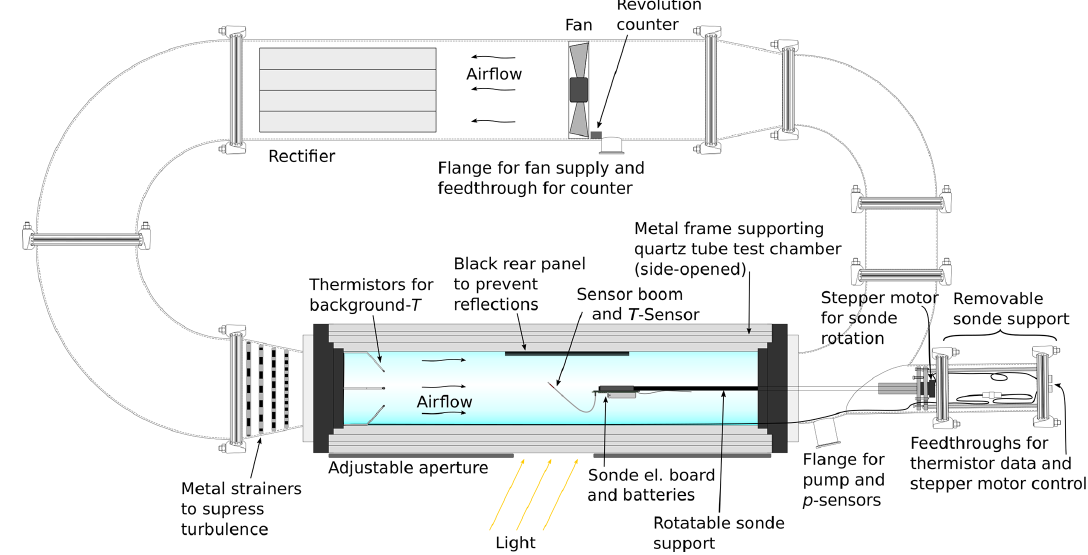
Figure 1. Schematic diagram of the SISTER radiation test chamber (top view). Table 1. Polynomial coefficients used in Eq. (1) for calculation of ventilation speed as function of pressure and fan rotation.